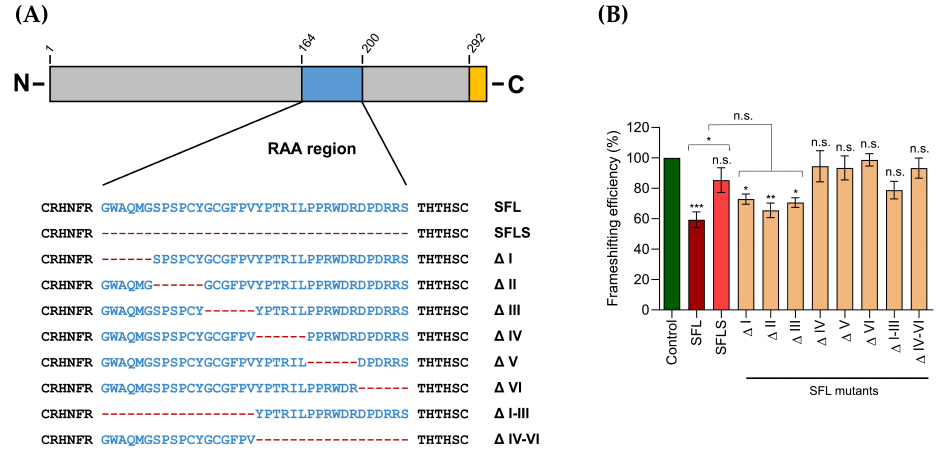
Figure 2. Deletions in the C-terminus of the RAA abrogate inhibition of –1PRF. ( A ) Sequences deleted from the RAA are shown. A C-terminal antigenic tag added for analysis of protein expression is shown in orange. ( B ) A549 cells were transfected with plasmids encoding SFL, SFLS, or SFL mutants together with –1PRF reporter vector. Luciferase signals in cell lysates were measured at 48 h post- transfection. A GFP expression plasmid served as a control. The average of five biological replicates conducted with technical triplicates is shown; error bars indicate SEM. One-way analysis of variance (ANOVA) with Dunnett‘s multiple comparison test was performed to determine whether differences between cells expressing GFP (control) and SFL, SFLS, or SFL mutants were statistically significant (not significant [n.s.]; *, p ≤ 0.05; **, p ≤ 0.01; ***, p ≤ 0.001; n = 5). Unpaired Student’s t -test